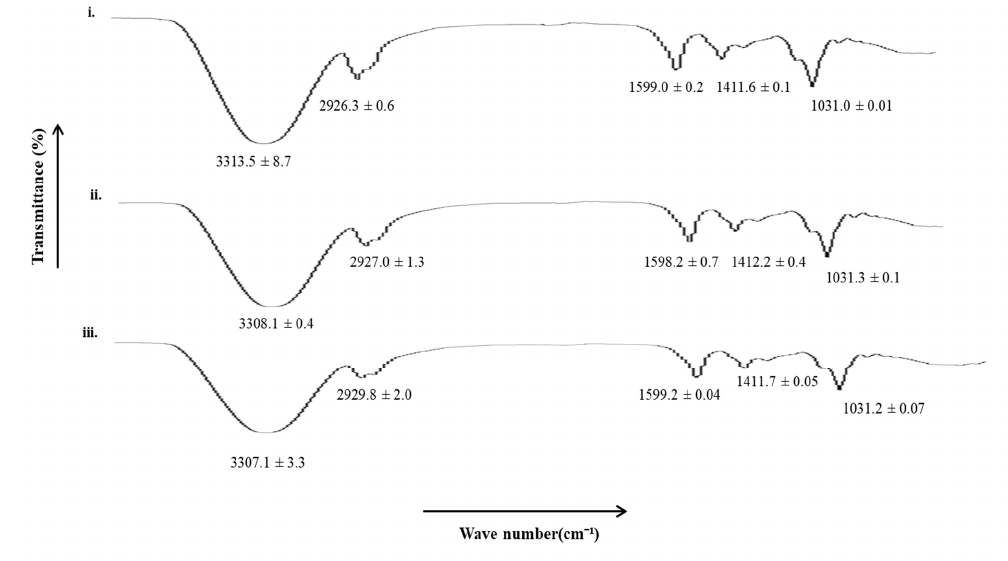
Figure 6. FTIR spectra of ( i ) UB, ( ii ) MB-1, and ( iii ) MB-3.